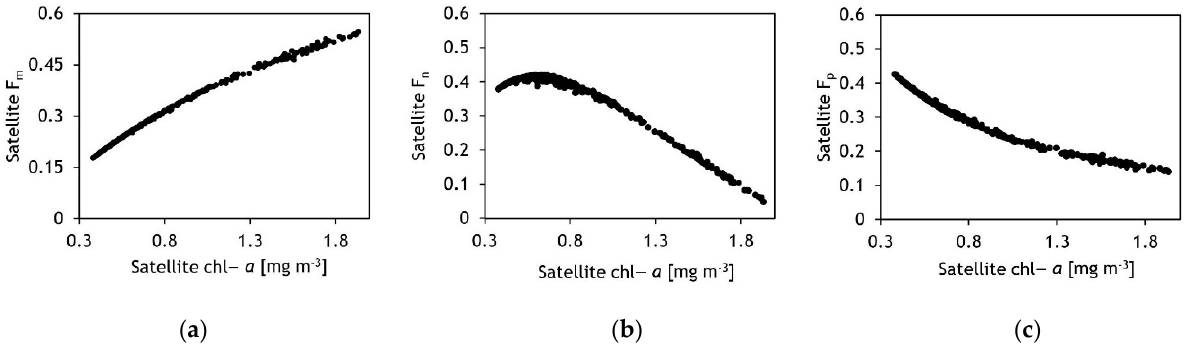
Figure 5. ( a – c ) shows the satellite − based PSC data extracted using a reparametrized three − compo ‐ nent model plotted against the reconstructed satellite chl − a .